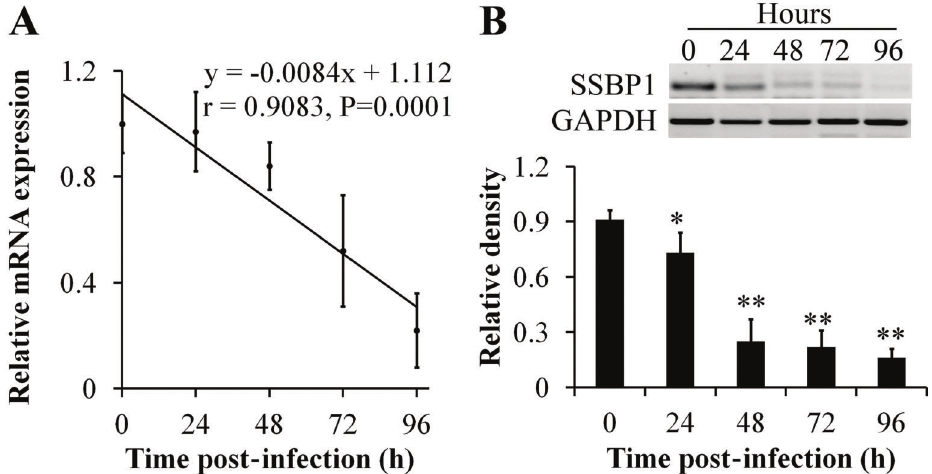
Figure 2. Human cytomegalovirus (HCMV) down-regulated the mRNA and protein expression of single-stranded DNA-binding protein (SSBP1). A , Expression levels of SSBP1 assayed by real-time PCR. B , Protein expression levels of SSBP1 assayed by western blot. Data are reported as means ± SE, (n=4). *P o 0.05 and **P o 0.01 compared to time 0 (ANOVA).